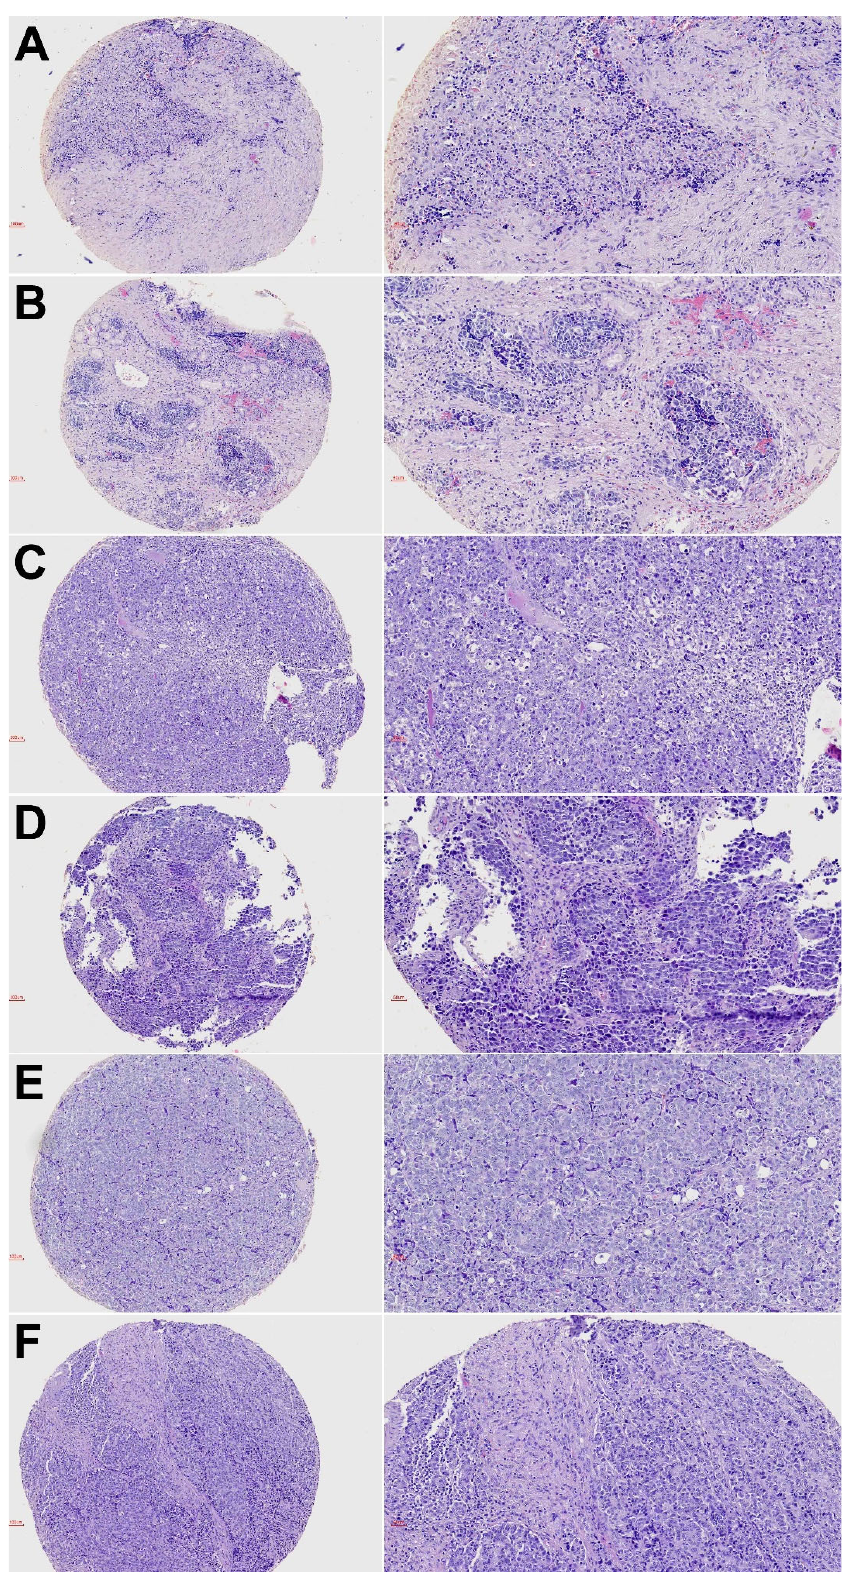
Figure 1. Hematoxylin and eosin stainings of representative cases from tumor subtypes ONB ( A ), SNEC ( B ), SNUC ( C ), PD-SNSCC ( D ), HG-non-ITAC ( E ) and solid-type ITAC ( F ). Left column × 100 and right column × 200